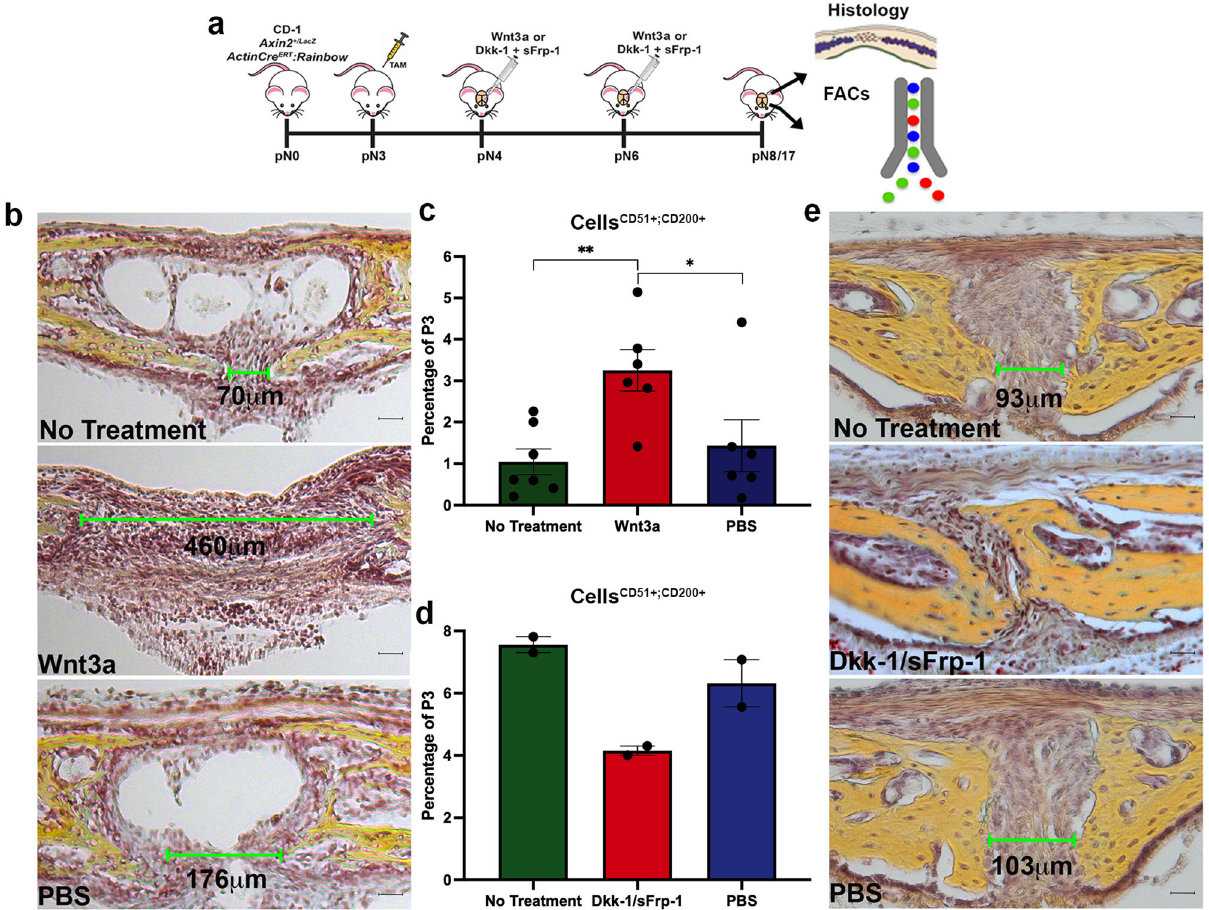
Fig. 4 Modulation of cWnt signaling affects CD51 + ;CD200 + cell frequency in the suture mesenchyme. a Schematic representation of the experimental procedures. TAM, Tamoxifen. b Movat ’ s pentachrome staining of coronal sections from CD-1 mouse PF sutures treated in vivo at day pN4 with Wnt3a (150ng) and harvested at day pN8 (normal onset of fusion). Movat ’ s pentachrome staining shows a largely expanded suture mesenchyme in Wnt3a-treated sutures relative to PBS and untreated controls. Top: no treatment, middle: Wnt3a, bottom: PBS. Green bars mark the distance between the two osteogenic fronts. Scale bars: 100 μ m. Magni fi cation at ×20. n = 3 animals/group, experiments were repeated 3 independent times. c FACS pro fi ling of freshly harvested Wnt3a-treated PF sutures at day pN8 reveals an increased representation of CD51 + ;CD200 + cells in these sutures relative to untreated and PBS controls. Values represent mean±SEM; Wnt3a vs No Treatment, P = 0.0025, Wnt3a vs PBS, P = 0.046 * P ≤ 0.05, ** P ≤ 0.01, unpaired, two-tailed student t -test were performed. n = 20 animals/group, experiments were performed 6 independent times. d FACS pro fi le of freshly harvested SAG sutures at pN8 following in vivo treatment with cWnt signaling inhibitors sFrp-1 (2 μ g) and Dkk-1 (2 μ g) or PBS. Treatment with inhibitors decreased CD51 + ;CD200 + cells in comparison to PBS and untreated controls. Values represent mean±SEM. n = 20 animals/group, experiments were performed two independent times. e Movat ’ s pentachrome staining of SAG sutures treated with cWnt signaling inhibitors sFrp-1 (2 μ g) and Dkk-1 (2 μ g) and relative controls at day pN17. Green bars mark the distance between the two osteogenic fronts. Scale bars: 100 μ m. Magni fi cation at ×20. Top: no treatment, middle: Dkk-1/sFrp-1, bottom: PBS. n = 3 animals/group, experiments were repeated 3 independent times. PF posterior frontal, SAG sagittal. Source data are provided as a Source data fi Remarkably, FACS analysis revealed that in Twist1 + / − :Axin2 lacZ/ + COR sutures, CD51 + ;CD200 + cells were restored to wild-type levels (Fig. 5b). Ensuing screening of the Twist1 + / − : Axin2 lacZ/ + double transgenic COR sutures for complete unilateral or bilateral craniosynostosis revealed a frequency of 0% in wild-type mice, as expected; 83% in Twist1 + / − mice; and 0% in Twist1 + / − :Axin2 lacZ/ + double transgenic mice. (Fig. 5c). Notably, a robust contribution of Axin2 + (LacZ + ) cells was observed within the mesenchyme of the Twist1 + / − :Axin2 lacZ/ + COR suture at day pN3, day pN18, and 6 months (Fig. 5d and Supplementary Fig. 10). Moreover, immunostaining of activated β -catenin revealed levels of endogenous active cWnt signaling within the COR suture mesenchyme of Twist1 + / − : Axin2 lacZ/ + double transgenic similar to that of wild-type and Axin2 lacZ/ + COR sutures (Supplementary Fig. 11a – d). Conversely, a faint immunostaining was detected in Twist1 + / − COR sutures.